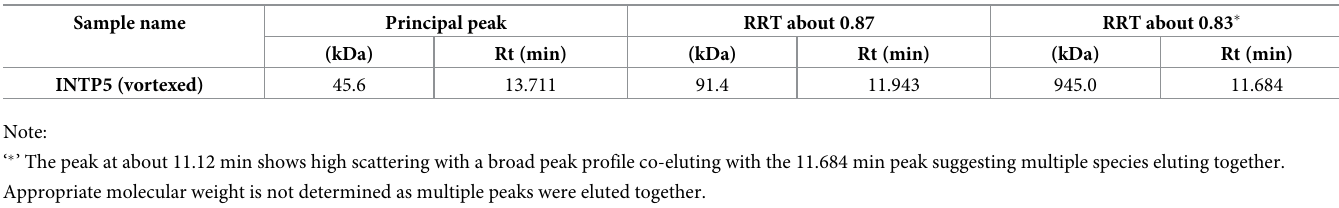
Table 8. Determination of Molecular Weight by SEC-MALS.